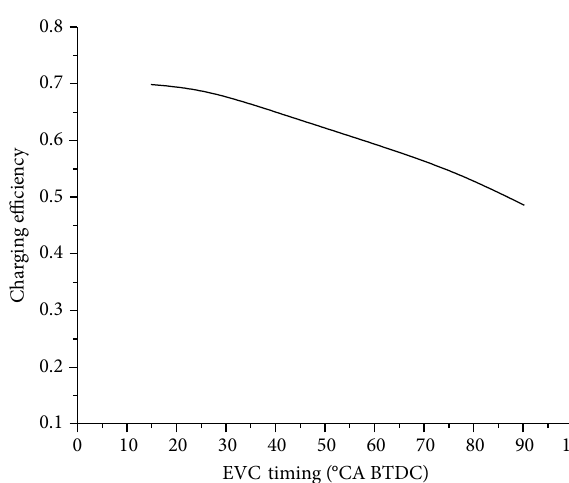
Figure 6: In fl uence of advanced degree of EVC timing on charging e ffi ciency.